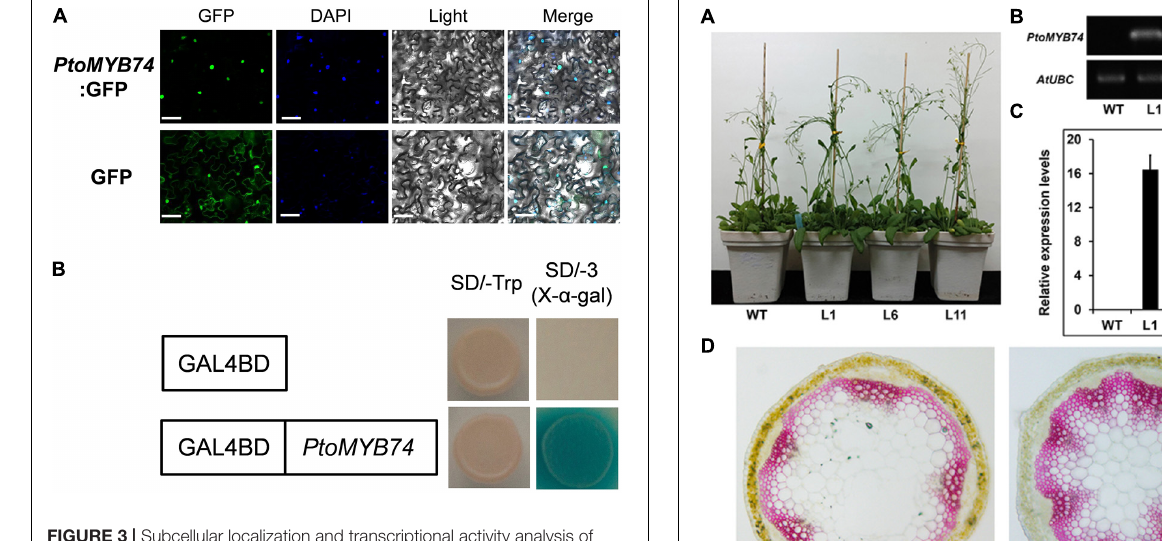
FIGURE 3 | Subcellular localization and transcriptional activity analysis of PtoMYB74. (A) Confocal images of localization of GFP-PtoMYB74 in tobacco leaf epidermal cells. Bright field and fluorescent micrographs show the nuclear localization of GFP-PtoMYB74 and free GFP expressed both in nuclear and cytomembrane localization in tobacco ( Nicotiana benthamiana ) leaf epidermal cells. DAPI (4 (cid:48) ,6-Diamidino-2-phenylindole dihydrochloride), a nuclear staining dye. Scale bars = 10 µ m. (B) The transcriptional activity assays in yeast cells. The yeast carrying GAL4BD-PtoMYB74 grew on a medium without Trp, His, and Ade (SD/–AHT) and induced the expression activity of X- α -Gal, while the negative control was not.